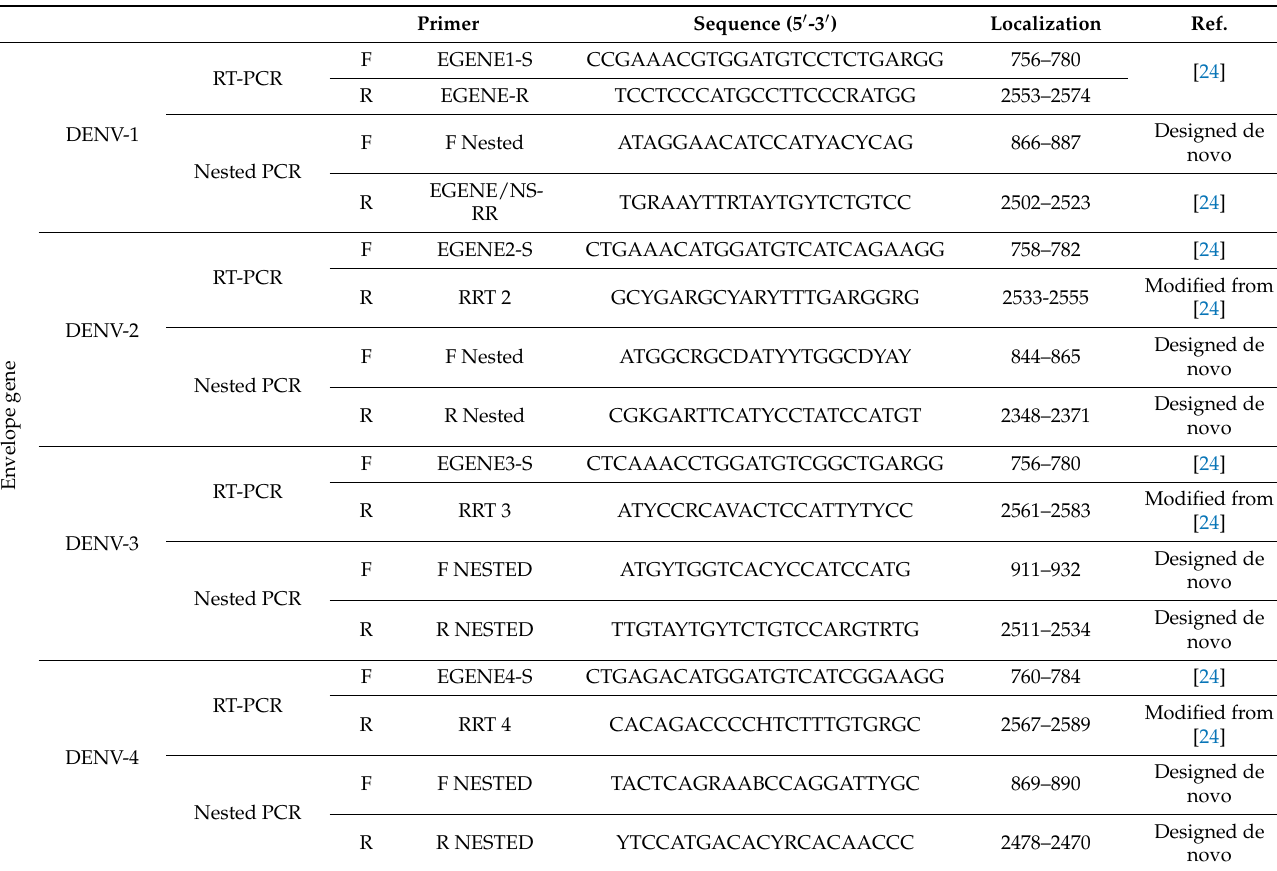
Table 1. Primers used in this study for amplification of the E gene and the NS1/E junction. For each DENV serotype, forward (F) and reverse (R) primers, their use in the first round RT-PCR or in the nested PCR and the reference are indicated. Primer Sequence (5 (cid:48) -3 (cid:48) ) Localization